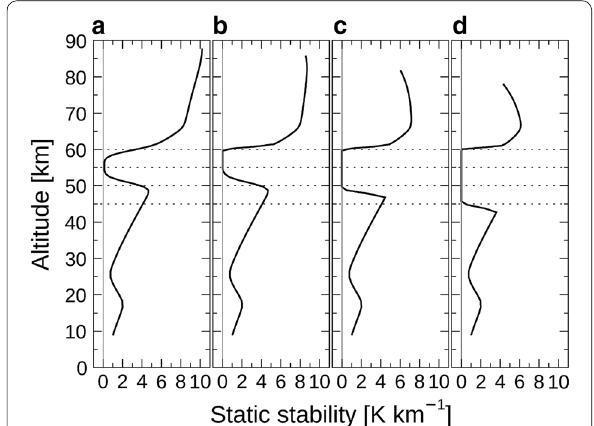
Fig. 2 Vertical profiles of the basic-state static stability on the equator. a Nominal case, b neutral layer thickness of 5 km, c 10 km, and d 15